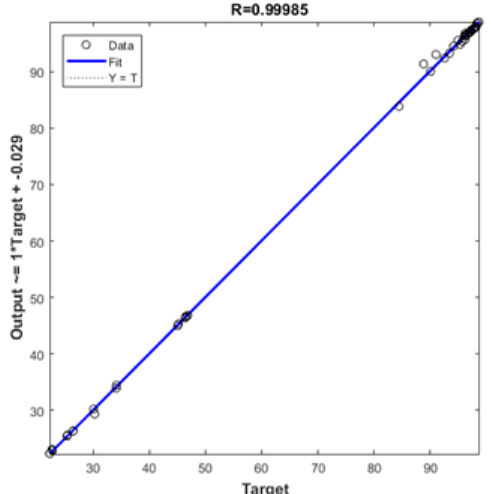
Figure 7. Regression of simulated data for the selected ANN model. Table 11. Statistical parameters of the ANN12 model for the newly tested data.